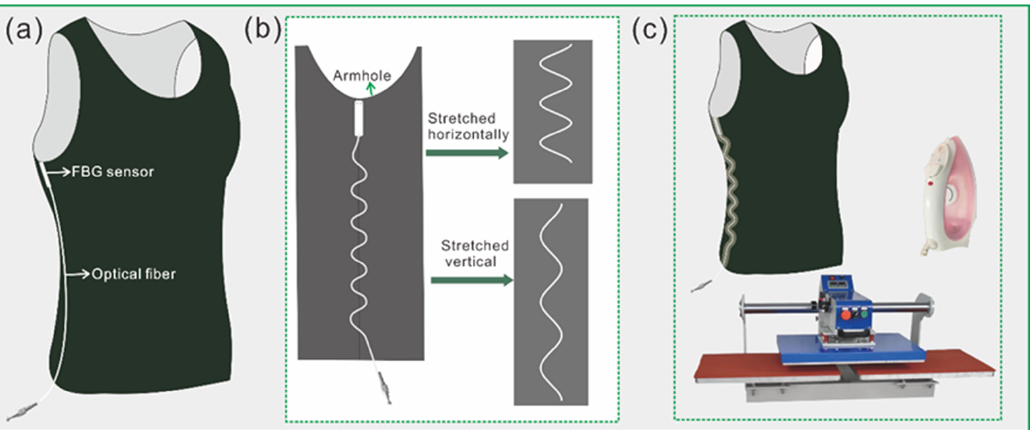
Figure 6. The integrated solution of the garment and FBG sensor. ( a ) The position of the FBG, ( b ) the path design of optical fiber, and ( c ) the method of the vest, the FBG sensor, and the optical fiber integration.